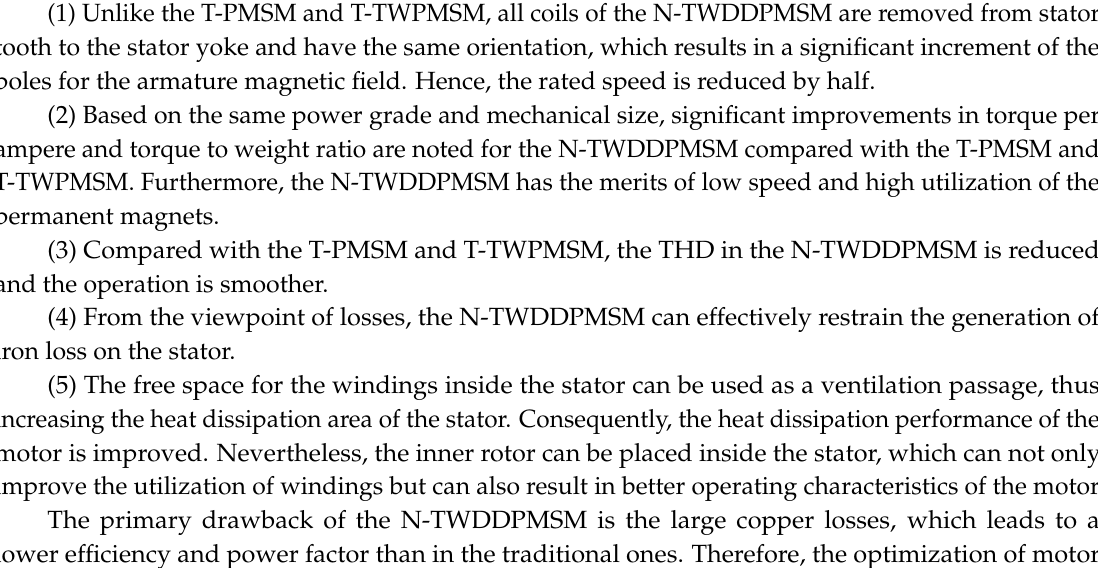
Figure15. Stator losses of three motors under rated operation. Figure 15. Stator losses of three motors under rated